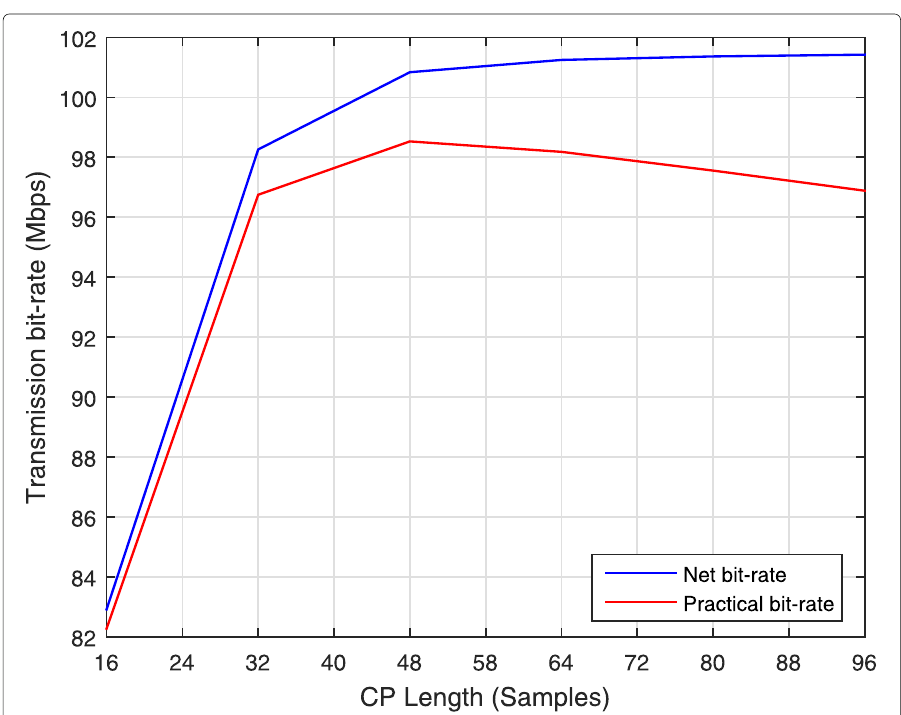
Fig. 14 Relationship between transmission bit rate and CP length